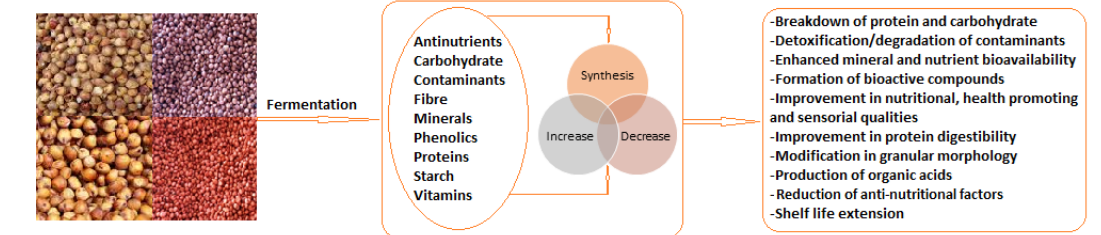
Figure 2. Modifications to sorghum during fermentation.